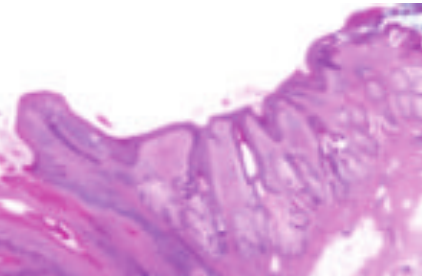
Figure 3: Pathological examination showed keratin lamellas which showed papillomatous improvement apart from any living cells.